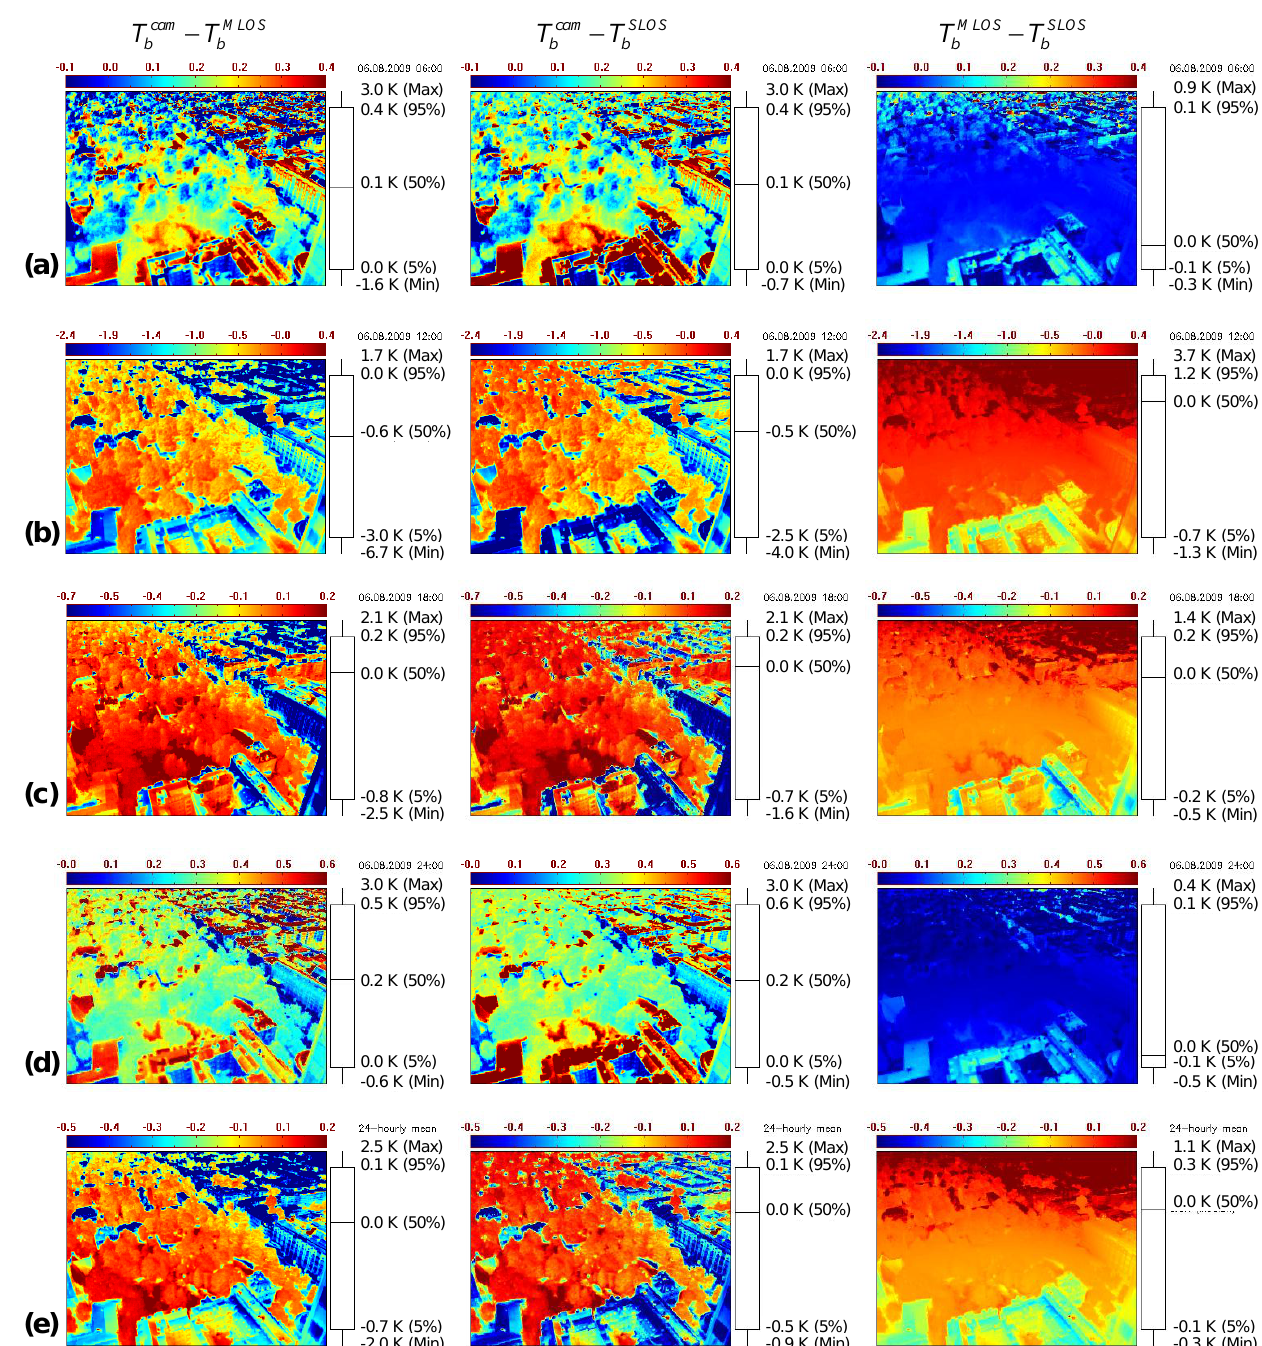
Fig. 7. Differences between T cam and T MLOS (left column), T cam and T SLOS (middle column) and between the two atmospheric correction b b b b − T SLOS methods ( T MLOS , right column) for selected 30-minute periods during 6 August 2009 at (a) 06:00, (b) 12:00, (c) 18:00 and b b (d) 24:00CET and (e) the 24-hourly mean